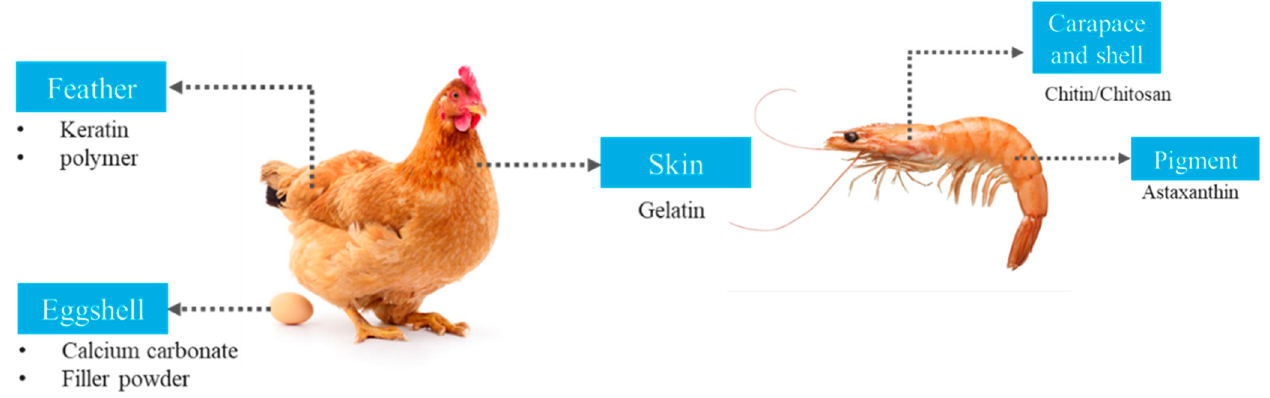
Figure 4. By-products from animal processing and their utilization. Table 4. Packaging developments utilizing animal waste products.